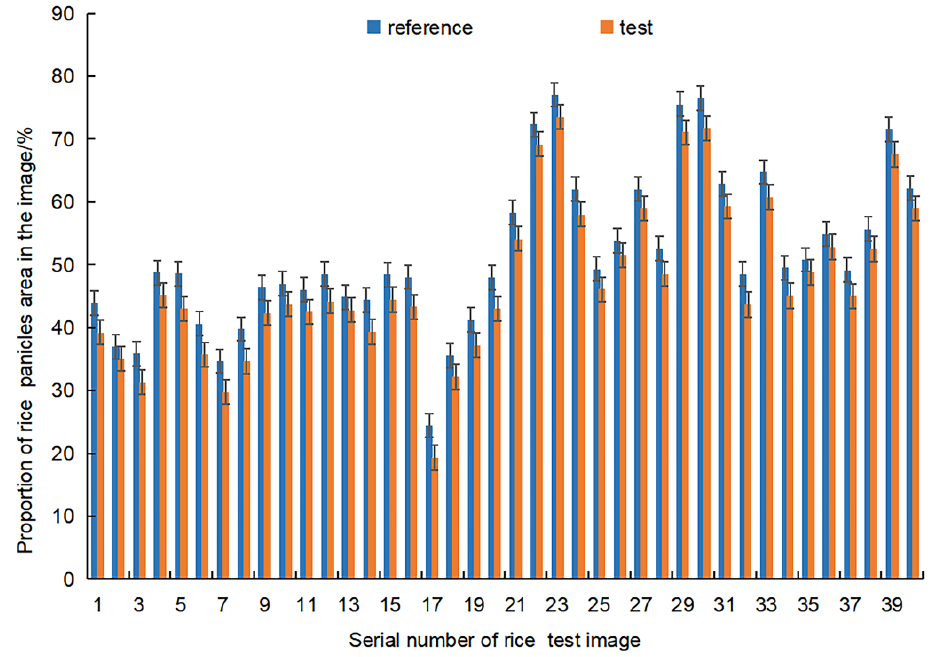
Figure 10. Comparison of the results of the proportional area of rice panicles.